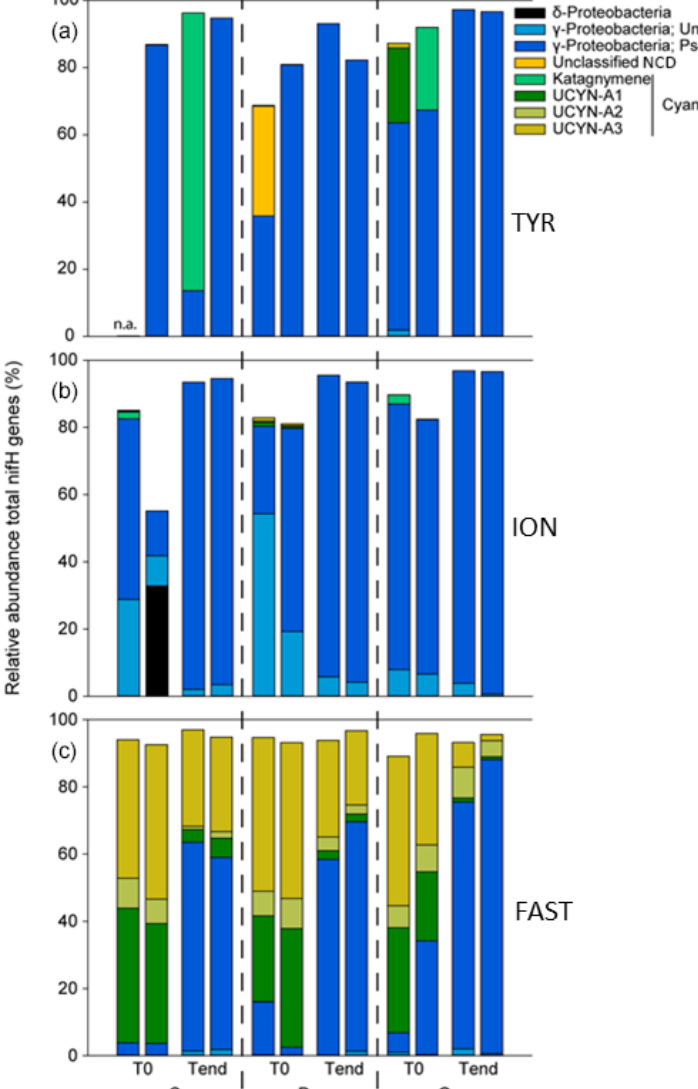
Figure 8. The composition of diazotrophs (based on 20 most abundant ASVs in the tanks) during the dust seeding experiments at the start (T0) and end (T3 at TYR and ION and T4 at FAST) in each tank at TYR (a) , ION (b) and FAST (c) . C1T0 at TYR was not included due to poor sequencing